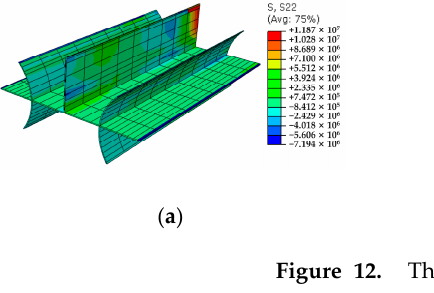
tion 1; ( b ) Condition 2; and ( c ) Condition 3.